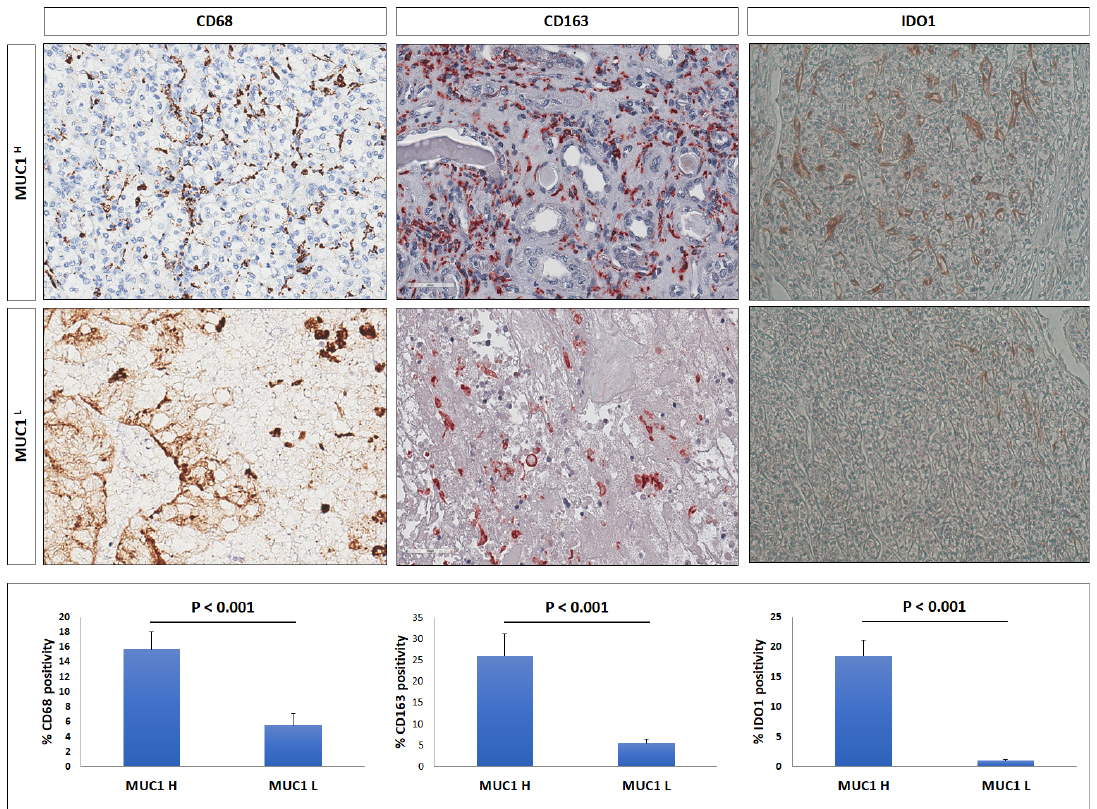
Figure 8. Immunohistochemical staining of CD68, CD163, and IDO1 in MUC1 H ccRCC compared with those in MUC1 L tumors. In addition, immunofluorescence and confocal laser scanning microscopy demon- strated the colocalization of the two markers (Figure 9), confirming the M2 polarization status of macrophages.